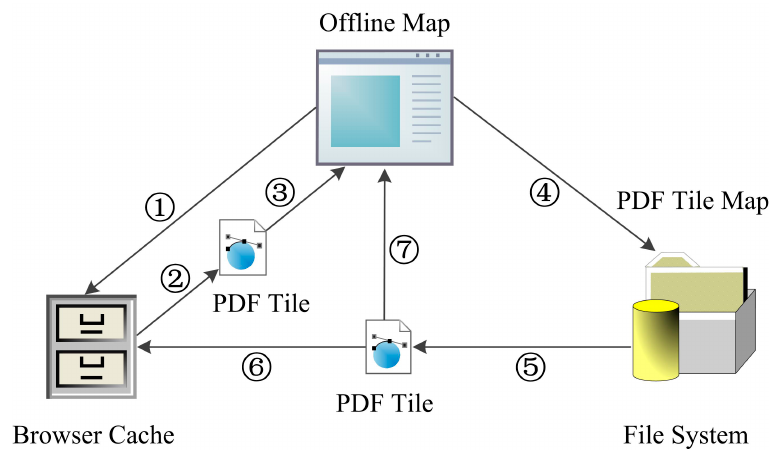
Figure 13. O ffl ine map system architecture. Numbers 1 and 4 denote the process of data request. Numbers 2, 3, 5, 6 and 7 denote the process of data transmission.